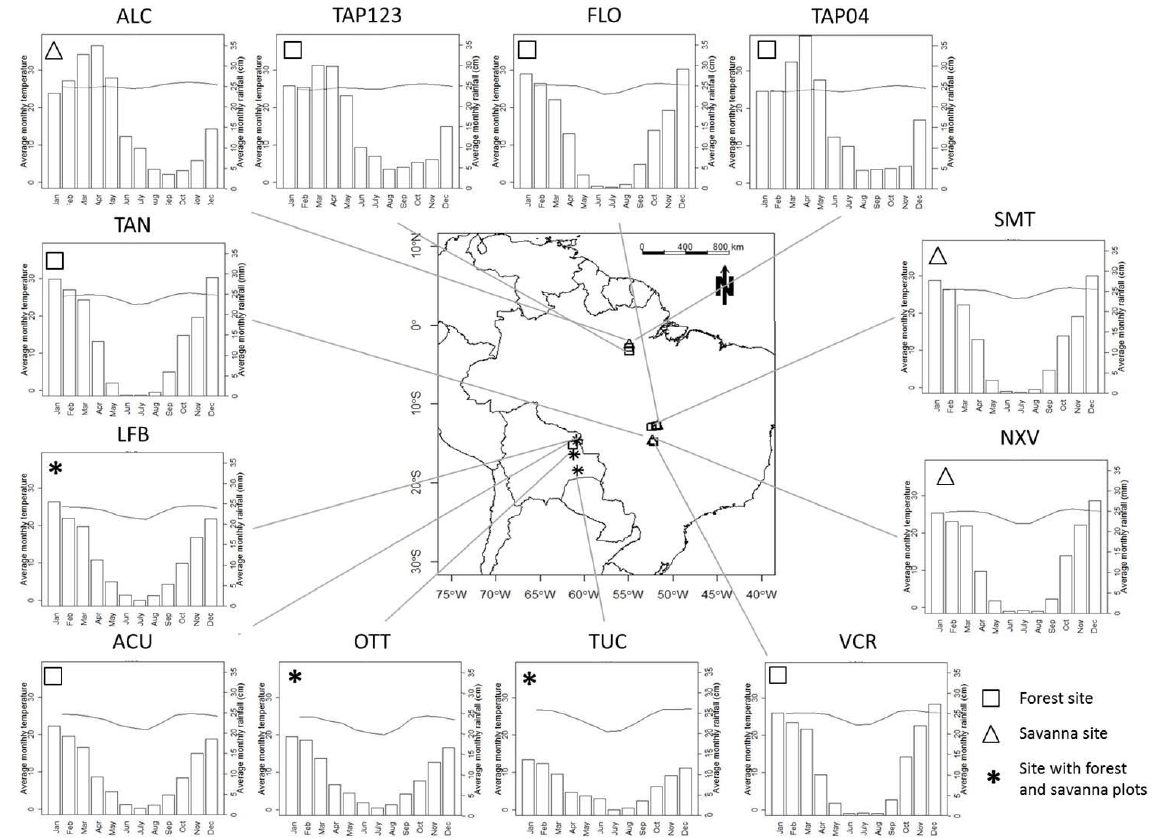
Figure 1. Map showing sampling sites and their temperature ( ◦ C) and precipitation